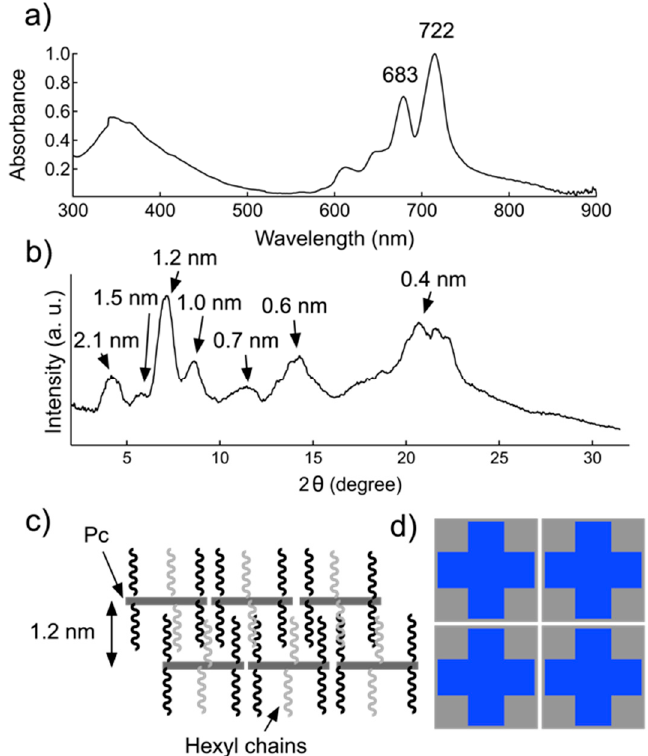
Figure 7. ( a ) Absorption spectrum and ( b ) XRD pattern of 1 film at room temperature. Schematic representation of the proposed structure of the crystalline phase of 1 : ( c ) view along the molecular z-axis, ( d ) view along the normal on the Pc xy-plane.